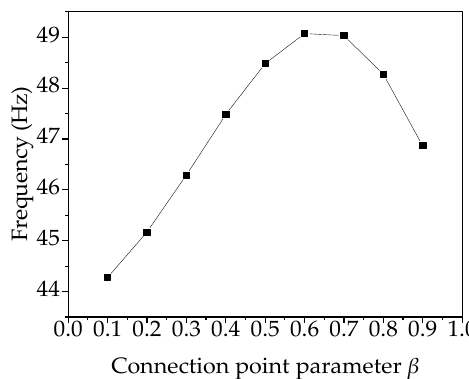
Figure 14. Relationship between the connection point parameter β and first-order frequency.